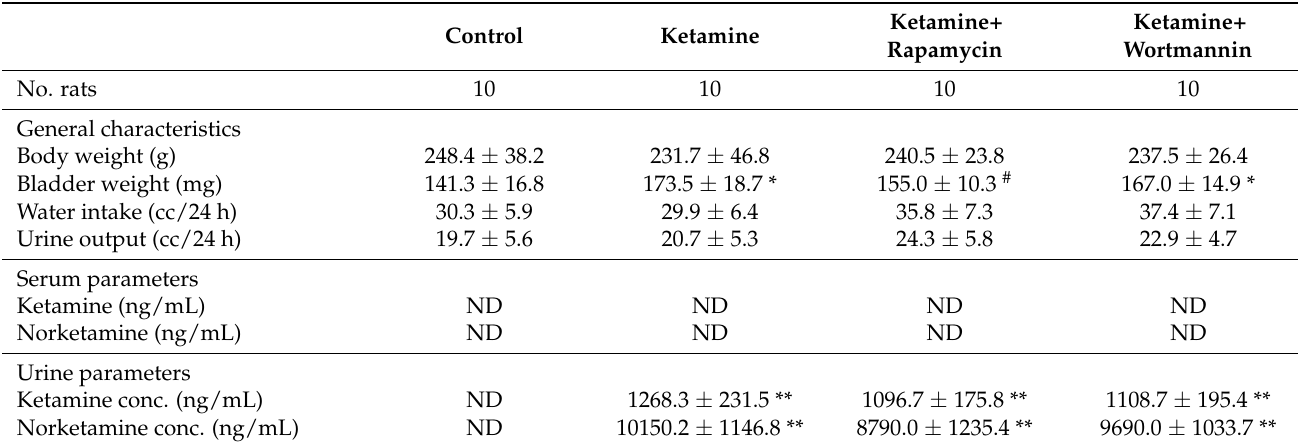
Table 1. General characteristics, urodynamic parameters, contractile responses, and count analysis of leukocytes for different experimental groups.